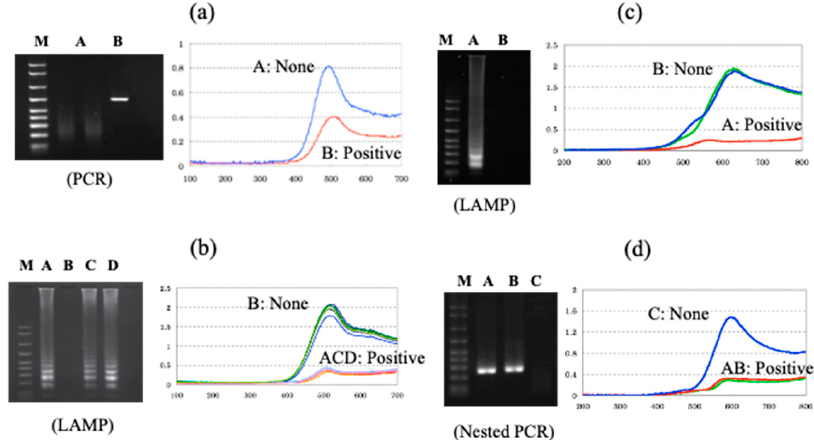
Figure 5. Various applications of our electrochemical DNA sensor ( a ) Salmonella gene amplified with PCR; ( b ) Pathogenic E.coli O157 gene amplified with LAMP; ( c ) Genetically modified maize gene amplified LAMP; ( d ) Hepatitis B virus (blood samples) gene amplified nested PCR. Each target was tested by electrochemical measurement and gel electrophoresis using positive and negative samples.